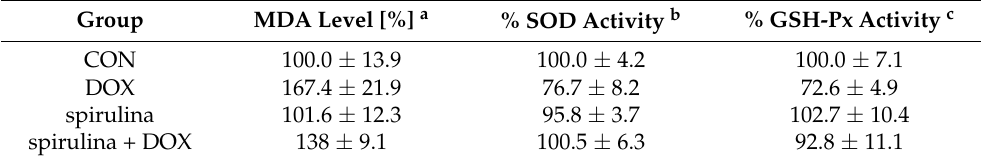
Table 10. The effect of DOX and spirulina on the level of cardiotoxicity markers in Wistar rats [16]. Group MDA Level [%] a % SOD Activity b